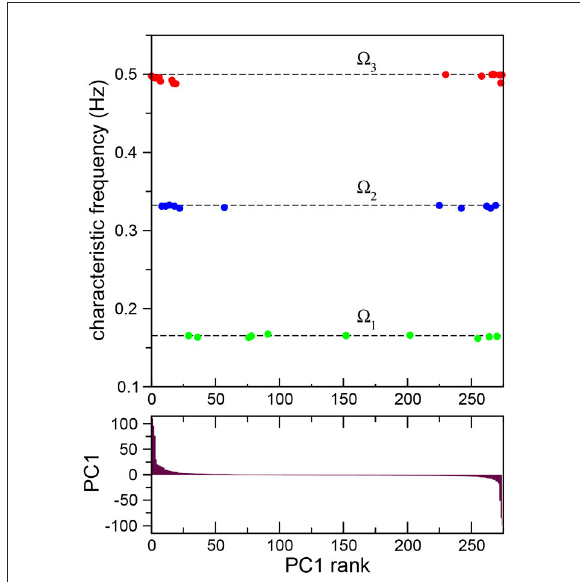
FIGURE3 Frequency synchronization sorted according to principal component analysis. Average Fourier transforms of neurons in three synchronized clusters (top) for a full 15 min long experiment sorted according to their first principal component PC1 (bottom) . The analysis reveals the presence of subclusters with opposite signs in their principal component